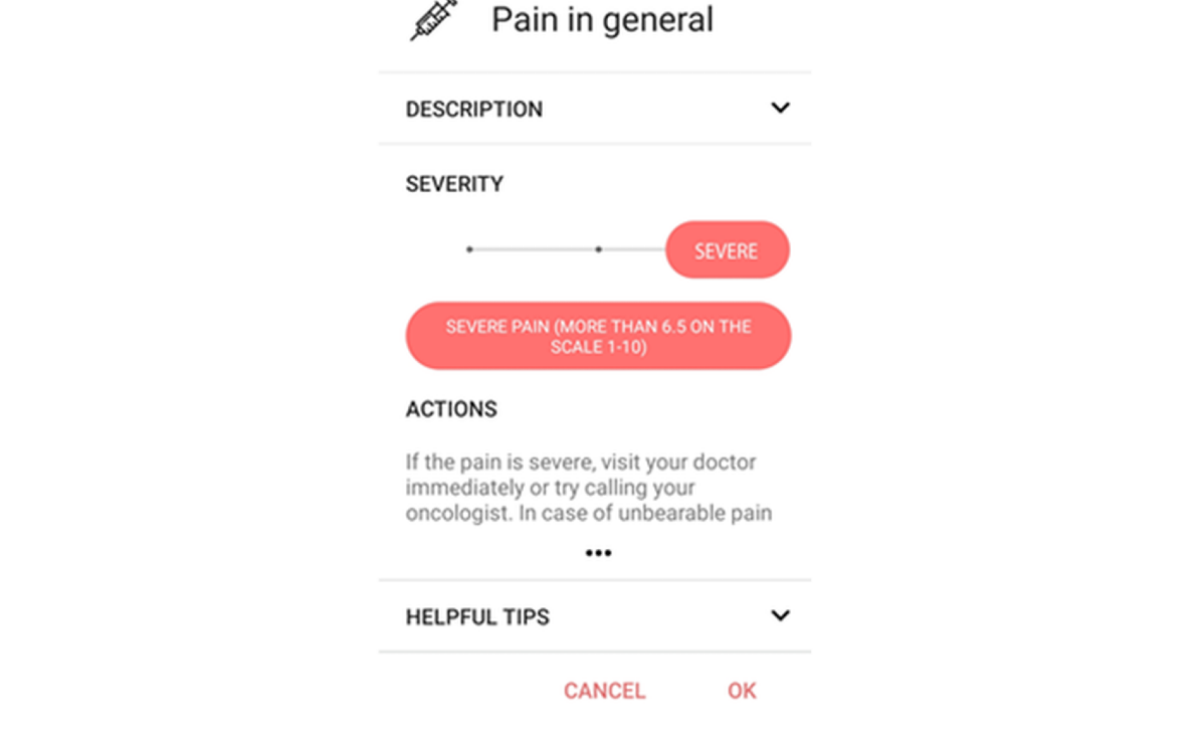
We selected 50 symptoms that were relevant to the